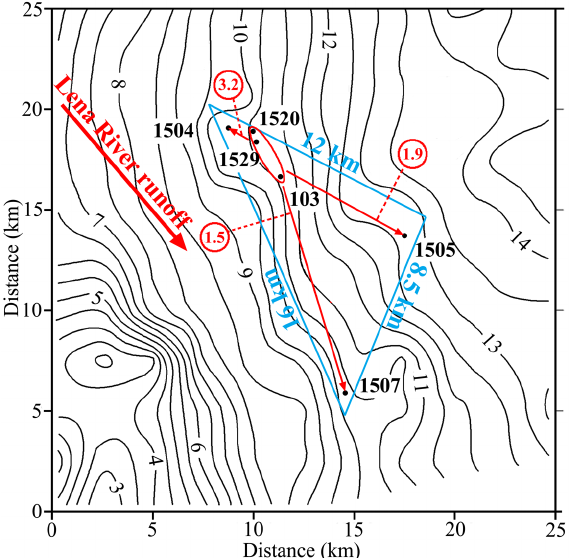
Figure 14. Scheme of box model mass-balance mixing for SGD in the studied area. Red ellipse – the proposed SGD location. Long red arrows show the direction of TGW plume movement, numbers in red circles show the residence time (days), blue triangle indicates the base of the prism for the box